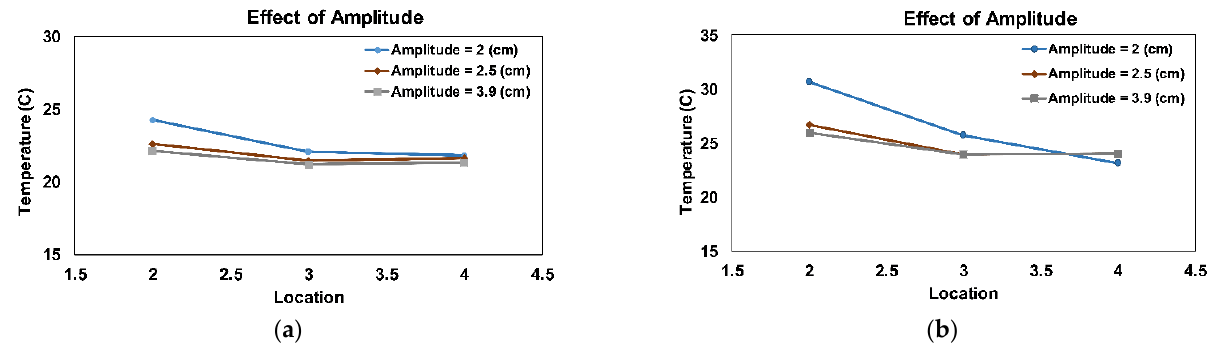
Figure 2. Effect of the amplitude on the surface temperature of the RMDHL, ( a ) input power 20 W ( b ) input power 60 W. ( b ) input power 60